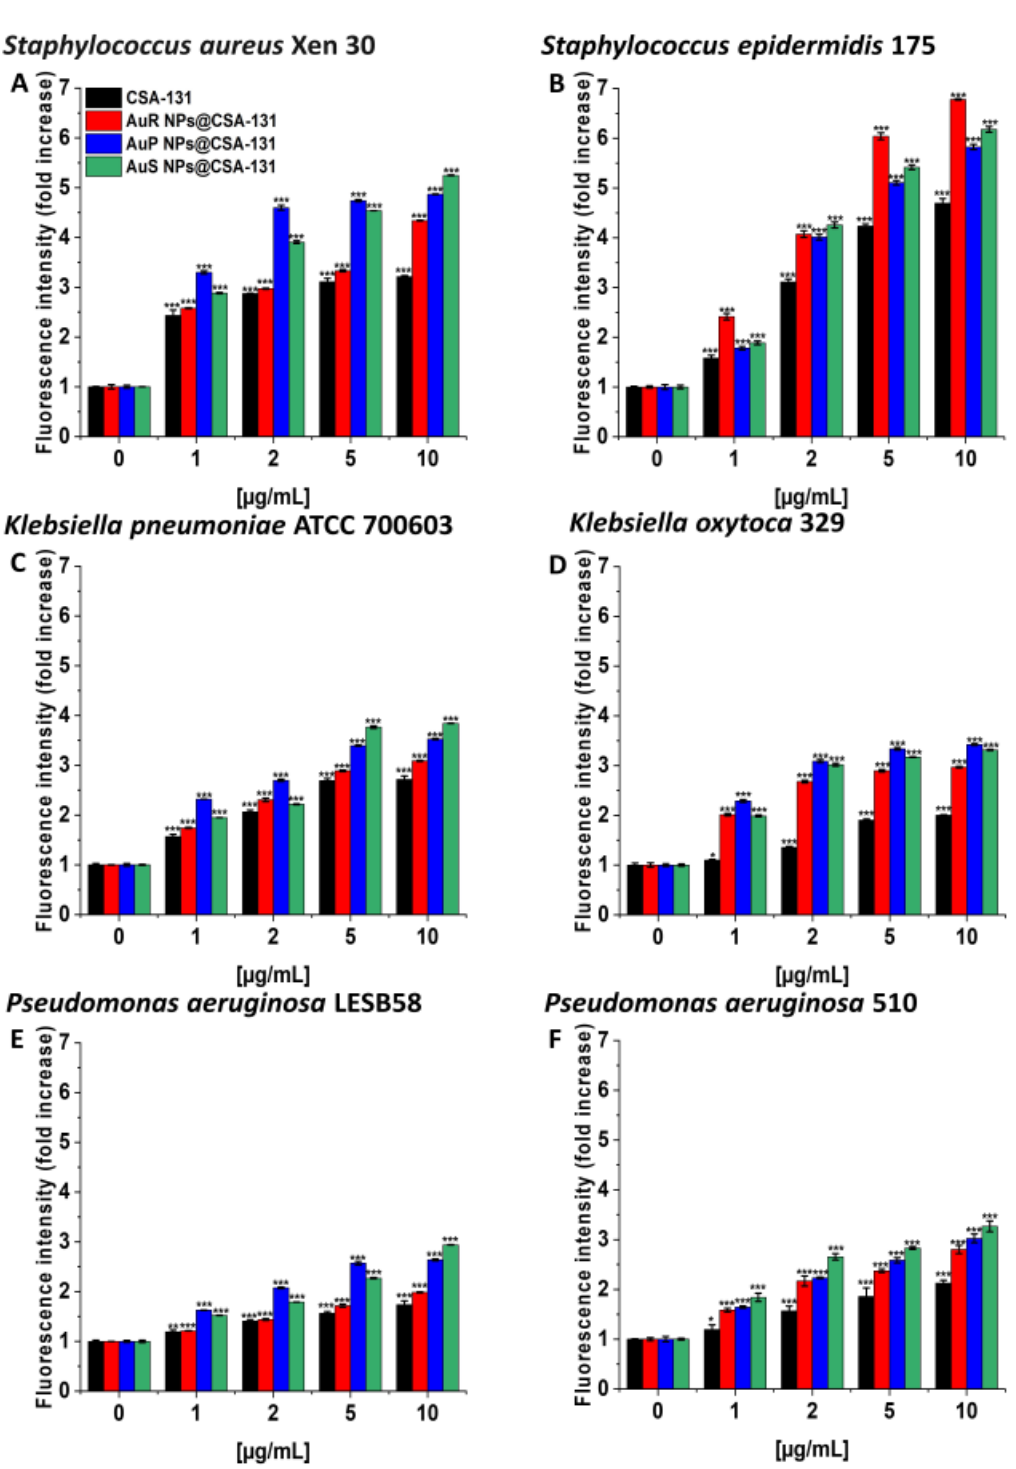
Figure 5. Depolarization of the bacterial membrane of Staphylococcus aureus Xen 30 ( A ), Staphylococcus epidermidis 175 ( B ), Klebsiella pneumoniae ATCC 700603 ( C ), Klebsiella oxytoca 329 ( D ), Pseudomonas aeruginosa LESB58 ( E ), and Pseudomonas aeruginosa 510 ( F ) was assessed using a diSC (3) assay. The evaluation of the degree of cell membrane depolarization in the presence of AuR NP@CSA-131, AuP NP@CSA-131, AuS NP@CSA-131, and CSA-131 ranging from 1 to 10 µg/mL was monitored by the enhancement of fluorescence intensity. Results show the mean ± SD, n=3; * indicates statistical significance at p ≤ 0.05, ** ≤ 0.01 and *** ≤ 0.001.